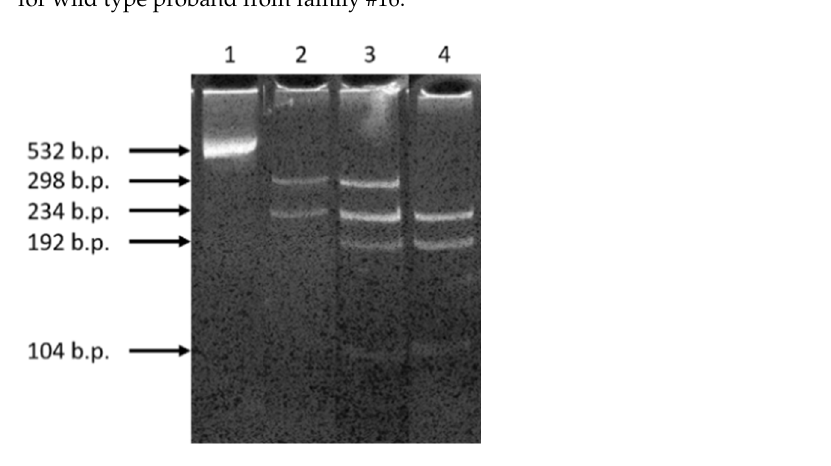
Figure 3. Electrophoregram of PCR-RFLP test-system performance for population screening for c.245A>G variant in GIPC3 gene. Lanes: 1—uncut fragment; 2—wild type fragment cut with Bst DEI restriction endonuclease; 3—heterozygous fragment cut with Bst DEI; 4—homozygous